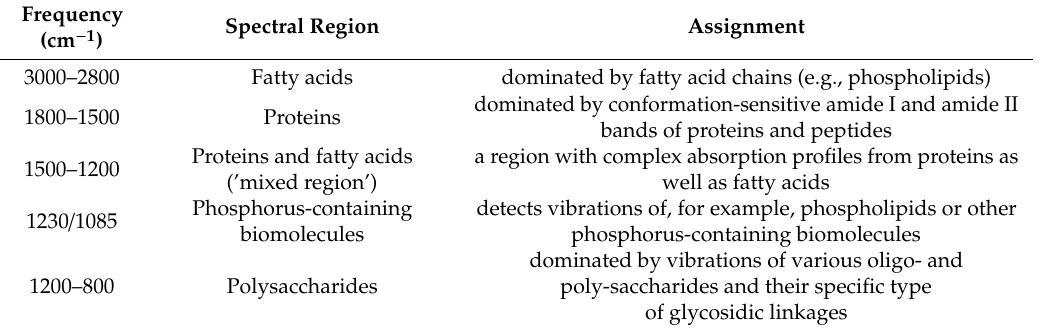
Table 1. Assignment of important Fourier-transform infrared (FTIR) spectral regions of